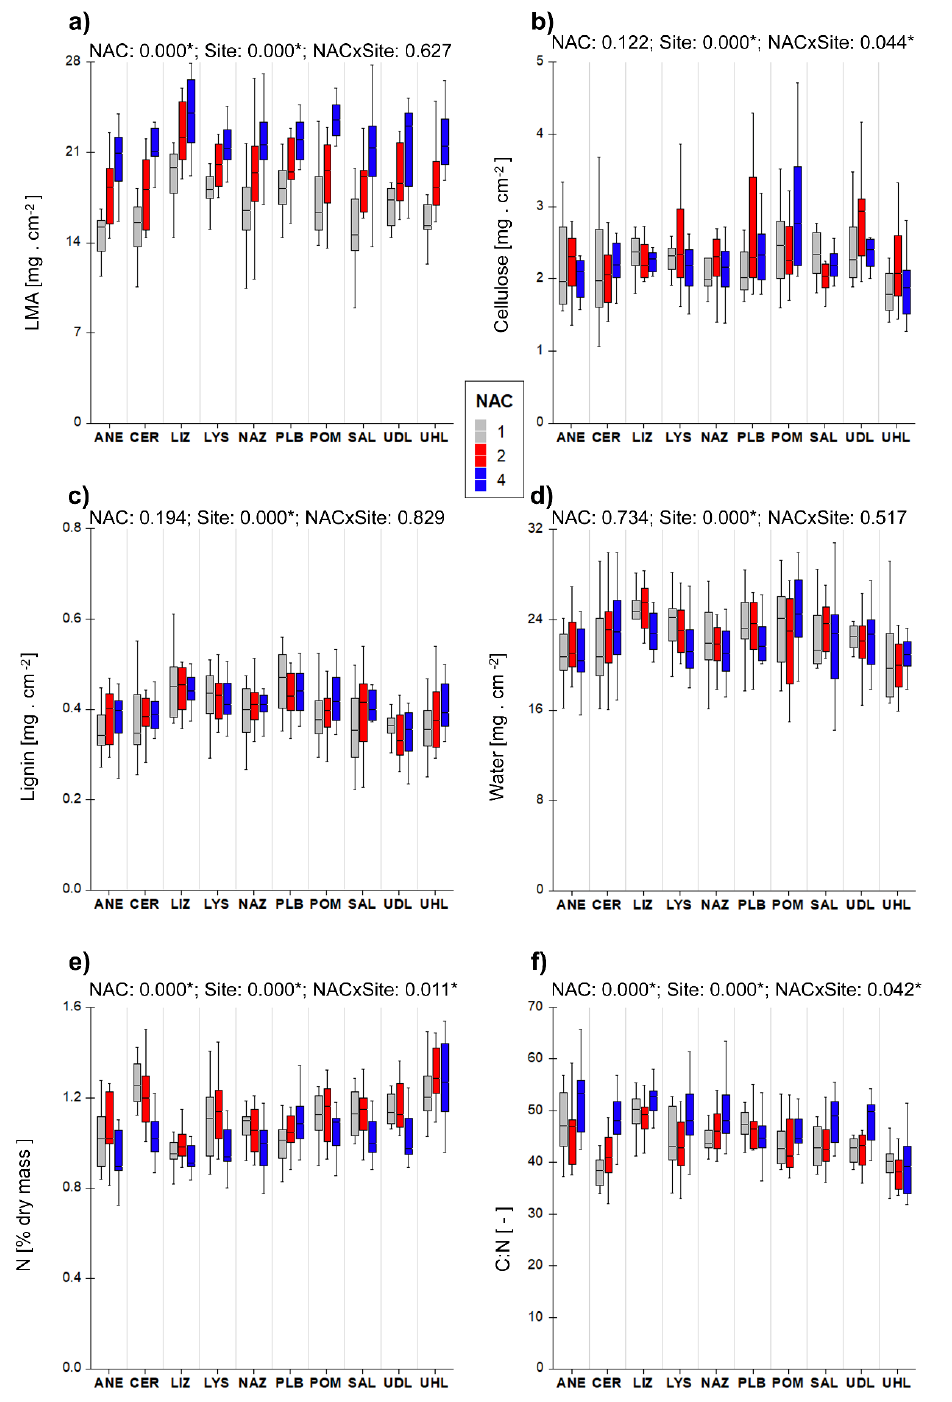
Figure 3. Needle traits according to their needle age and site location corresponding to different headwater catchments (see description in Table 1). ( a ) Leaf dry mass per area (LMA); ( b ) cellulose content; ( c ) lignin content; ( d ) water content; ( e ) nitrogen content (% of dry mass); ( f ) C:N ratio in needles at ten GEOMON sites (ANE, CER, LIZ, LYS, NAZ, PLB, POM, SAL, UDL and UHL). NAC—needle age class: 1—current year needles; 2—previous year needles; 4—four year and older needles. Two-way ANOVA, effect of needle age, site, and their interaction (NAC x Site): p -values; *—significant at α =